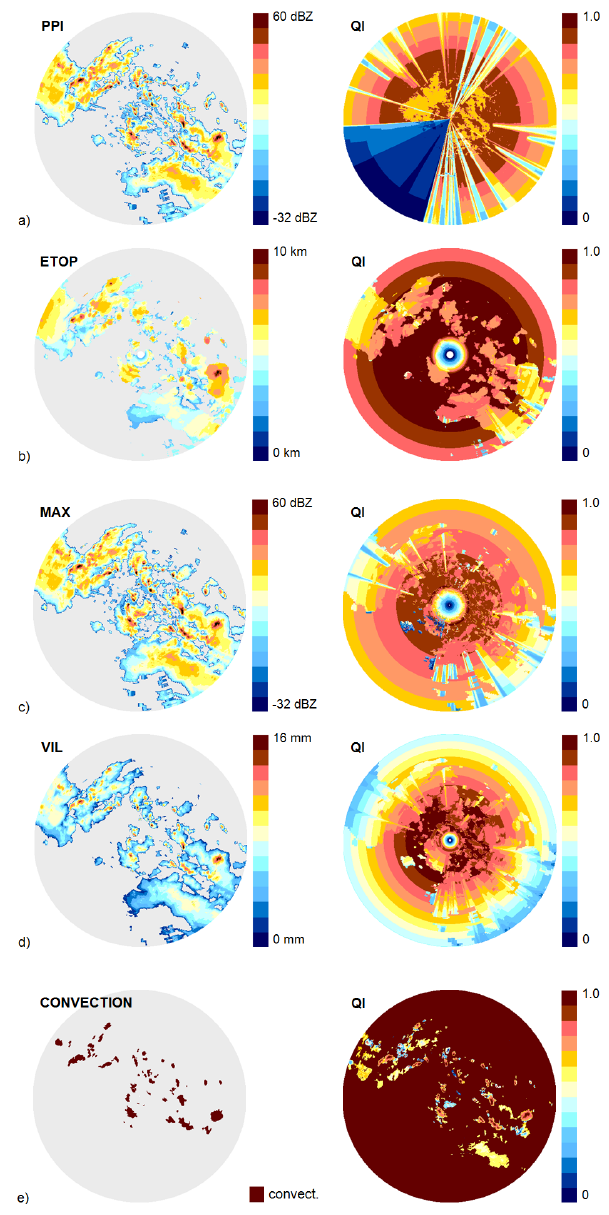
Figure 5. Cartesian radar products with their quality fields: (a) PPI at 0.5 ◦ , (b) ETOP with 4dBZ as cloud boundary, (c) MAX, (d) VIL, (e) CONVECTION (Brzuchania radar, 27 May 2014, 14:30UTC, distance up to